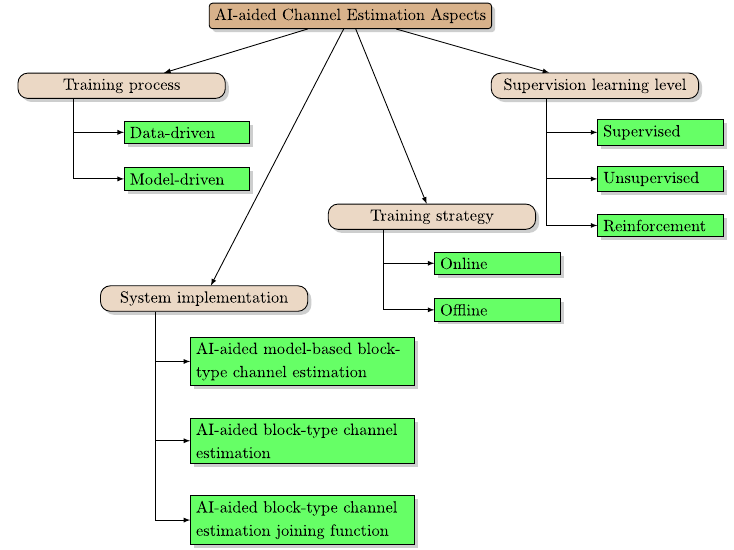
Fig. 4 AI-aided channel estimation